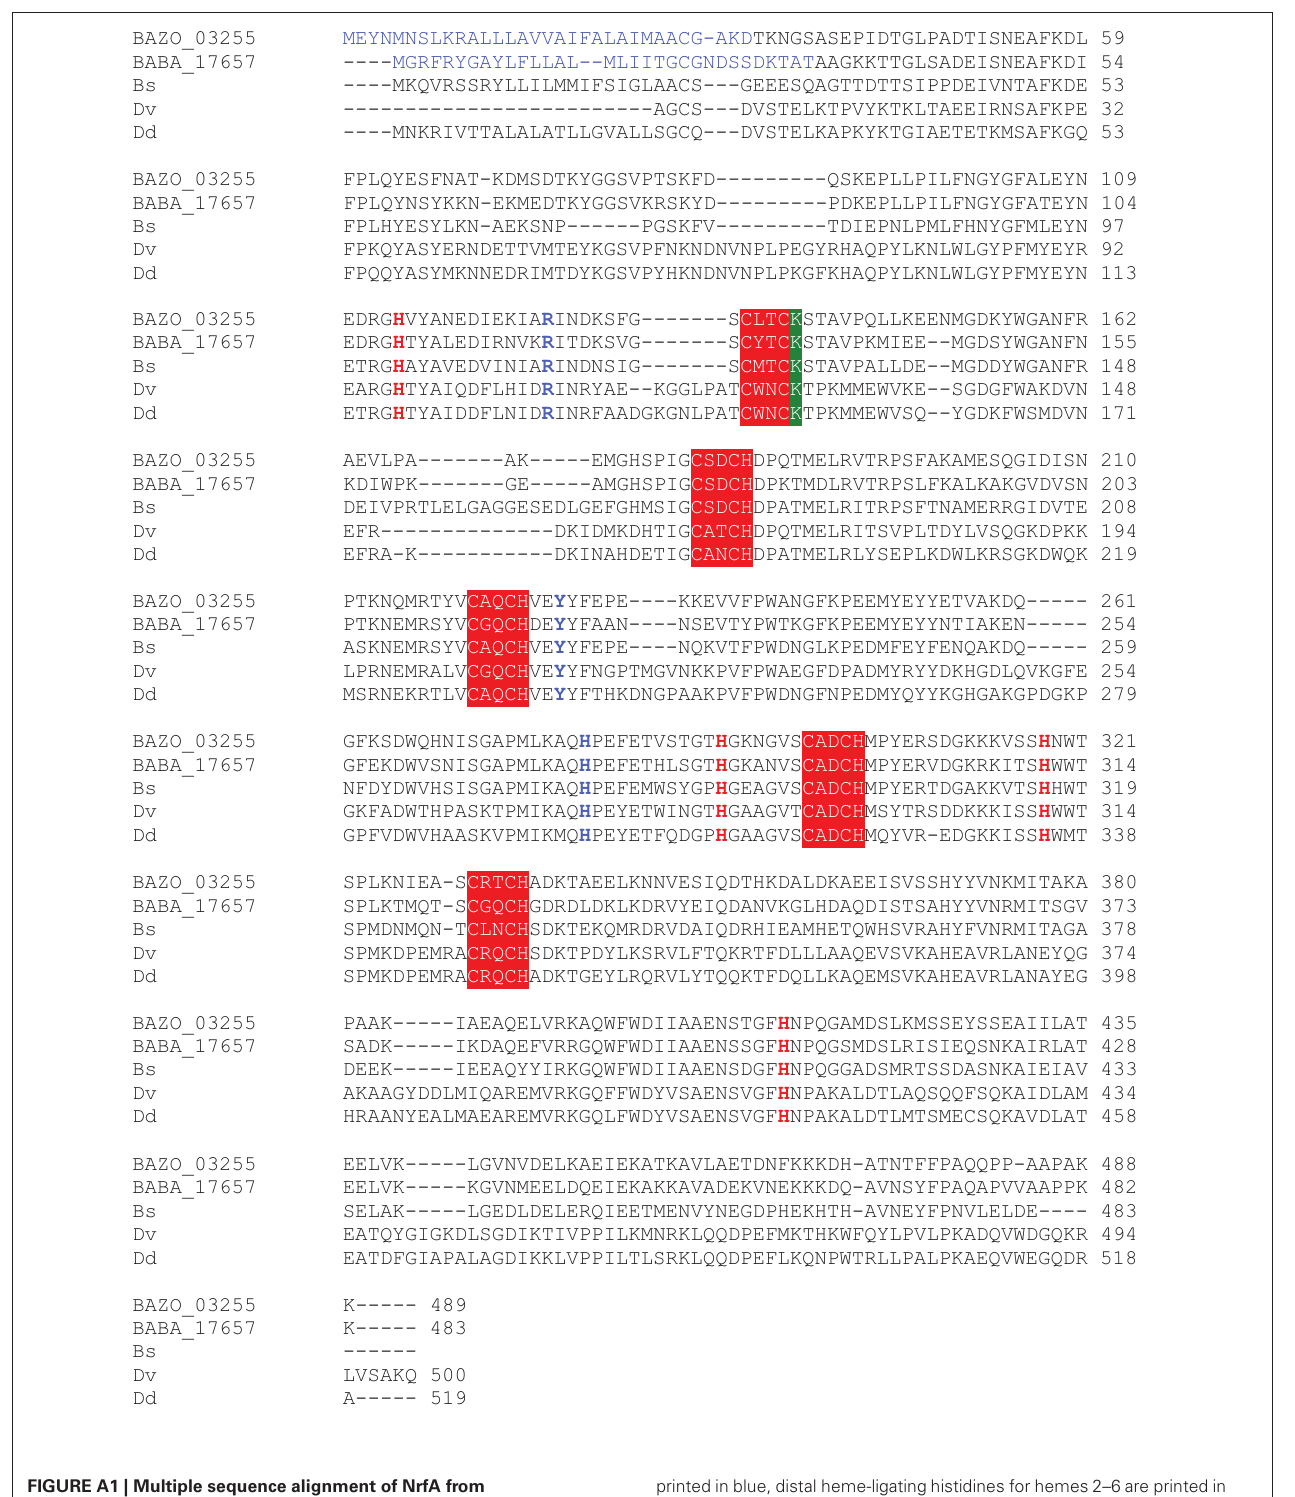
printed in blue, distal heme-ligating histidines for hemes2–6 are printed in red [according to Einsle et al. (2000)].Bs, Bacillus selenitireducens MLS10 (Bsel_1305); Dv, Desulfovibrio vulgaris DP4 (PDB 2J7A); Dd, Desulfovibrio desulfuricans (PDB 10AH_A). PDB, protein database accession number.